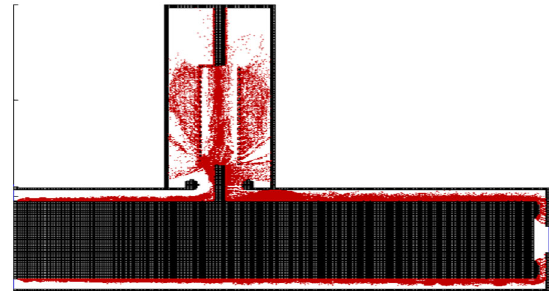
FIG. 16. Electron phase space in the YZ plane with electron emission on the helical surface. This simulation was conducted under different conditions with that of Fig. 14 to exam the influence of electron emission to helical performance. The cathode diameter is 24 cm and MITL voltage is 550 kV. The A-K distance of the diode is 15 mm. Electron emission turns on when the electric field exceeds 20 kV = cm for helical. The simulated anode currents are 113 kA at z ¼ 0 : 3 m and 103.5 kA at z ¼ 0 : 692 m , indicating nearly 10 kA loss across the helical support.